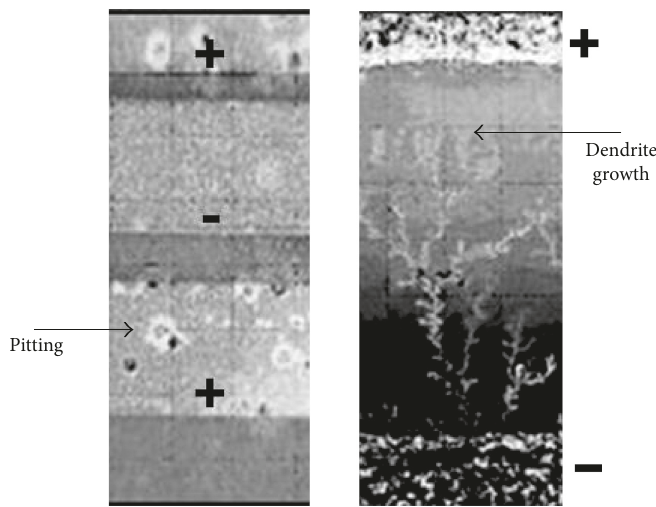
Figure 1: Corrosion phenomena on a PCB based on EM under high electric field